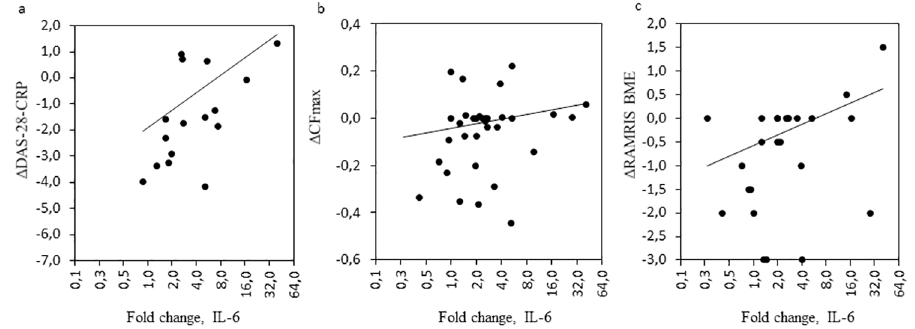
Fig 2. Scatter plots depicting fold changes in explant IL-6 production versus changes in DAS-28, CFmax and RAMRIS BME. Scatter plots depicting fold changes (2 week/72h) in IL-6 versus changes in DAS-28 (16 patients, 40 explants), CF max (N = 15, 38 explants) and RAMRIS BME score (N = 11, 28 explants) among bDMARD-treated patients. Correlations were calculated using Spearman’s rank coefficients and P-values were calculated using mixed effects models for the imaging data A) ρ = 0.56, P = 0.03; B) ρ = 0.52, P = 0.04; C) ρ = 0.56, P = 0.03. bDMARD = in vitro added biologic Disease Modifying Anti-Rheumatic Drug; CFmax = maximal color fraction,; DAS-28 = Disease Activity Score of 28 joints including C reactive protein; IL-6 = interleukine 6; RAMRIS BME = Rheumatoid Arthritis Magnetic Resonance Imaging Score for Bone Marrow Oedema.